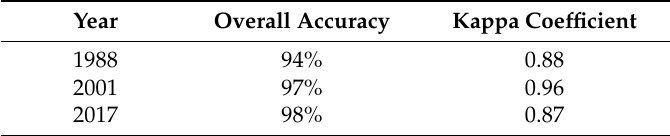
Table 3. The overall accuracy of classified land